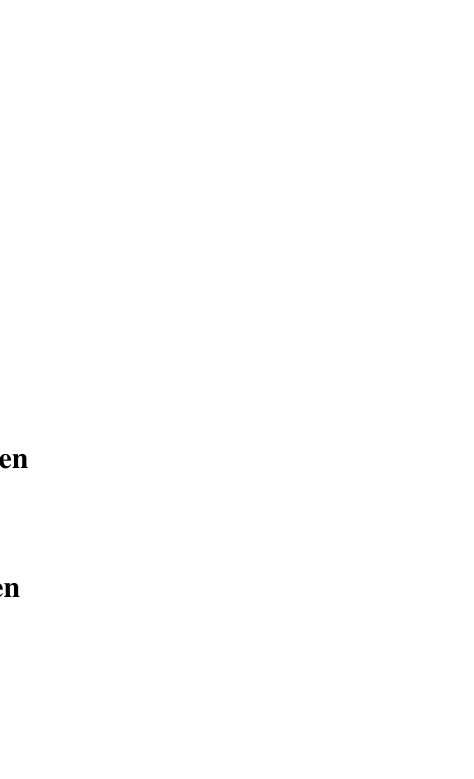
Algorithm 1: The Cluster-head (CH) and Vice-CH election. for s ← 1 to #nodes